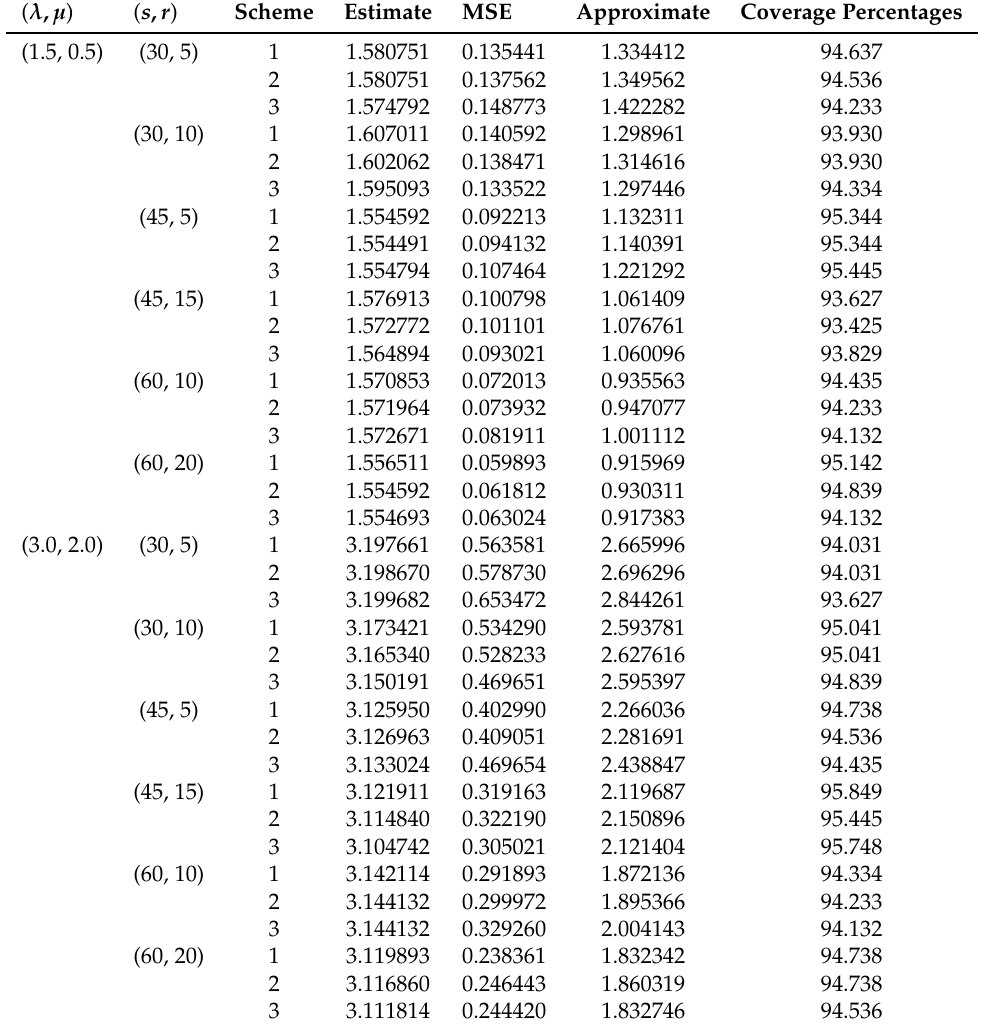
Table 7. Average values of estimate of λ with their respective mean sum of squares (MSEs), Average confidence interval and coverage percentages.